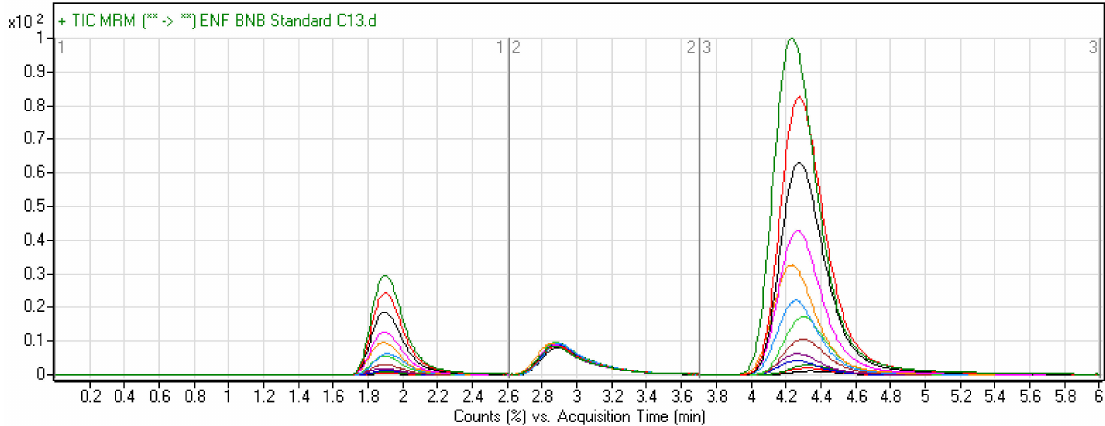
Figure 6. Overlaid MRM chromatograms of BNB at concentrations of 5.0–500.0 ng/mL at 1.89 min, AVB at a concentration of 100 ng/mL at 2.88 min, and ENF at concentrations of 5.0–500 ng/mL at 4.32 min. Standards and QC levels are exhibited in different colors: 500 (green), 400 (red), 300 (black), 200 (fuchia), 150 (orange), 100 (aqua), 80 (lime), 50 (maroon), 30 (purple), 20 (blue), 15 (olive), 10 (light red), and 5 (dark gray). Table 1. ENF and BNB concentration data back-calculated from the HLM matrix calibration levels. Concentration in ng/mL